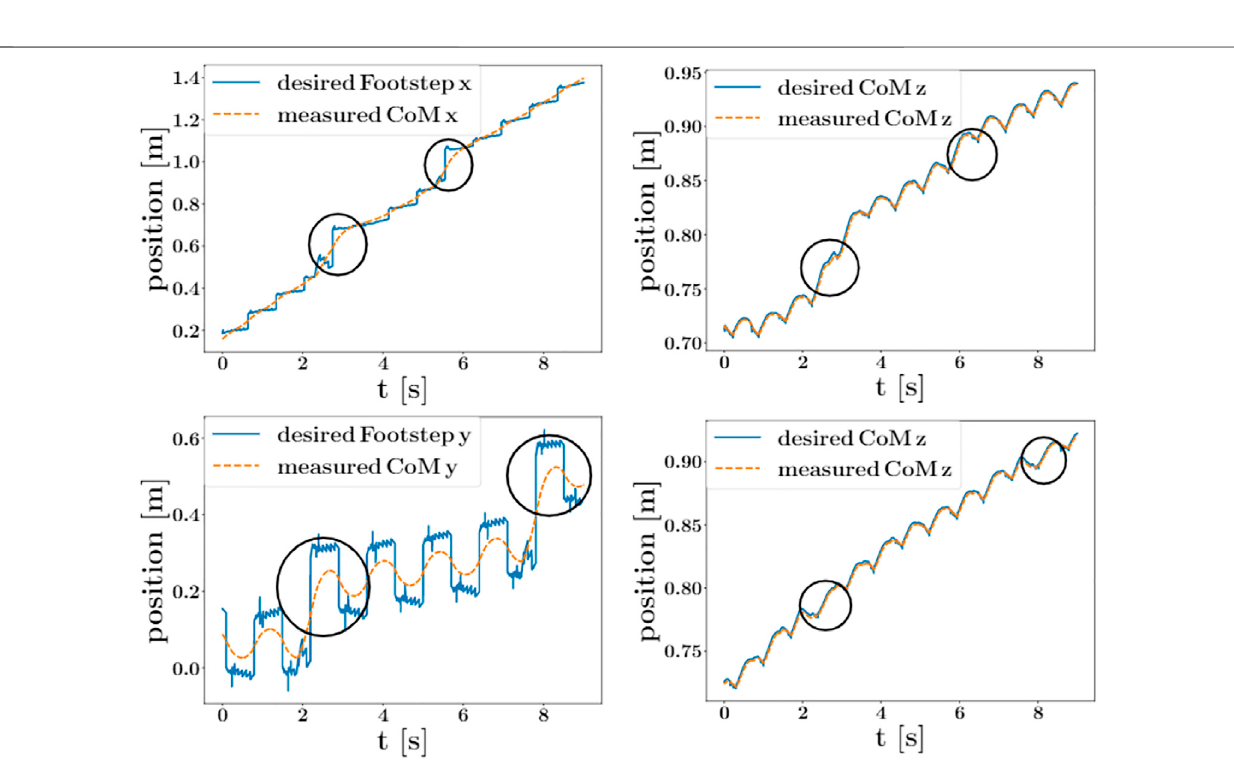
Frontiers in Robotics and AI |